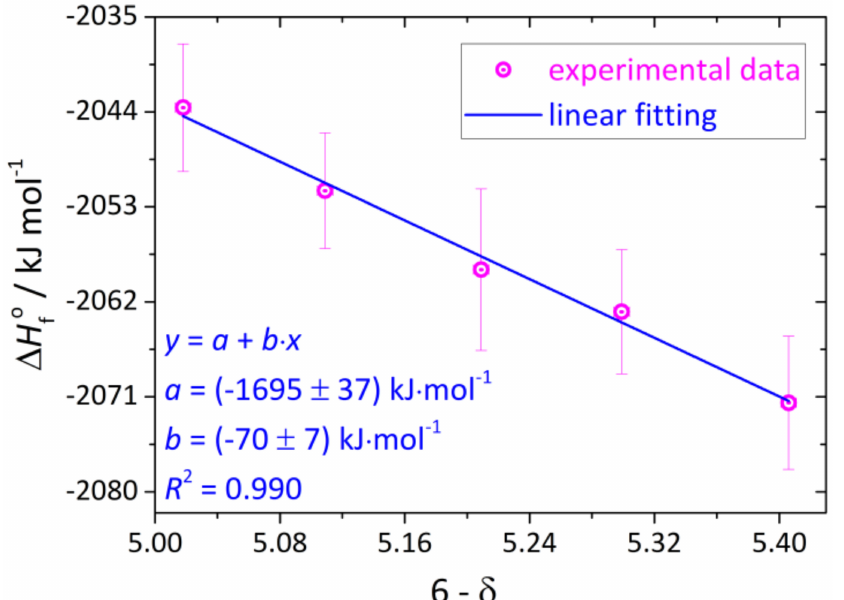
Figure 6. The standard formation enthalpy of YBC at 298.15 K as a function of its oxygen nonstoi- chiometry. Vertical and horizontal error bars correspond to expanded uncertainties at the level of confidence ≈ 95%. Table 6. Standard formation enthalpies at 298.15 K, ∆ H f ◦ , of the studied YBC samples. (6- δ ) in